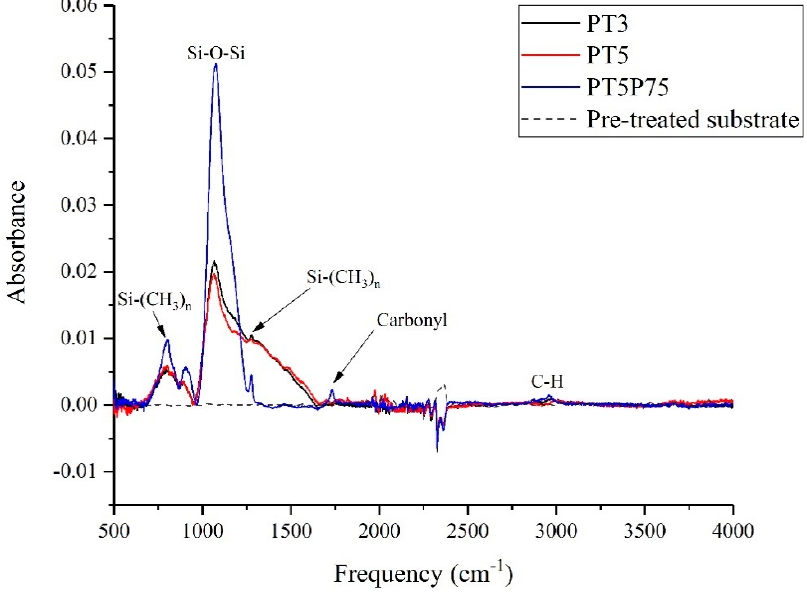
Figure 9. Full range of Fourier transform infrared spectroscopy (FTIR) spectra acquired from PT3, PT5, and PT5P75.